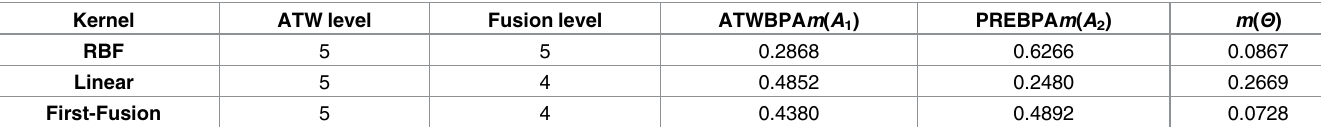
Table 7. The fusion results of the first step.